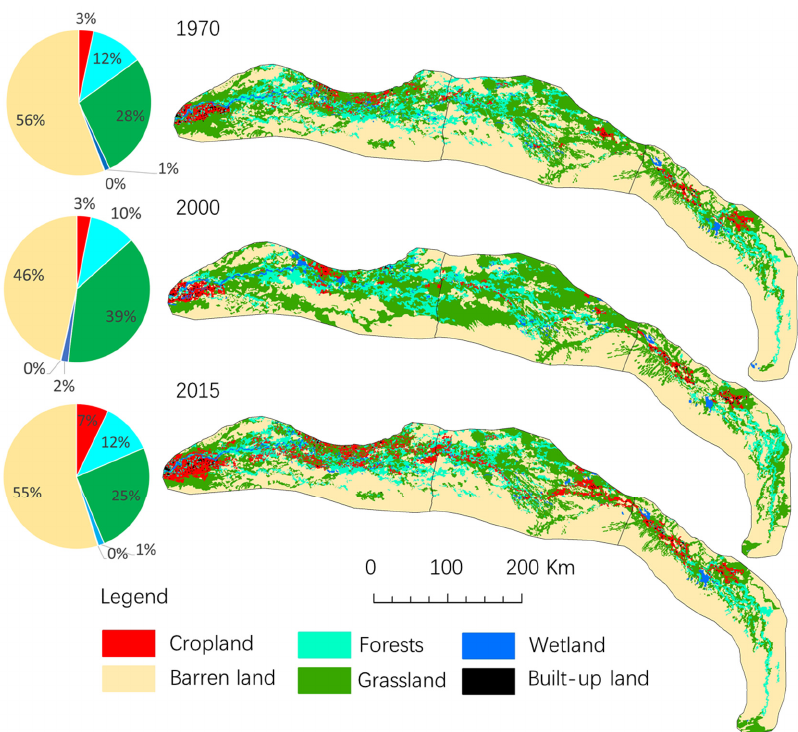
Figure 3. Land-use and area percentages in the mainstream Tarim River basin in 1970, 2000, and 2015.